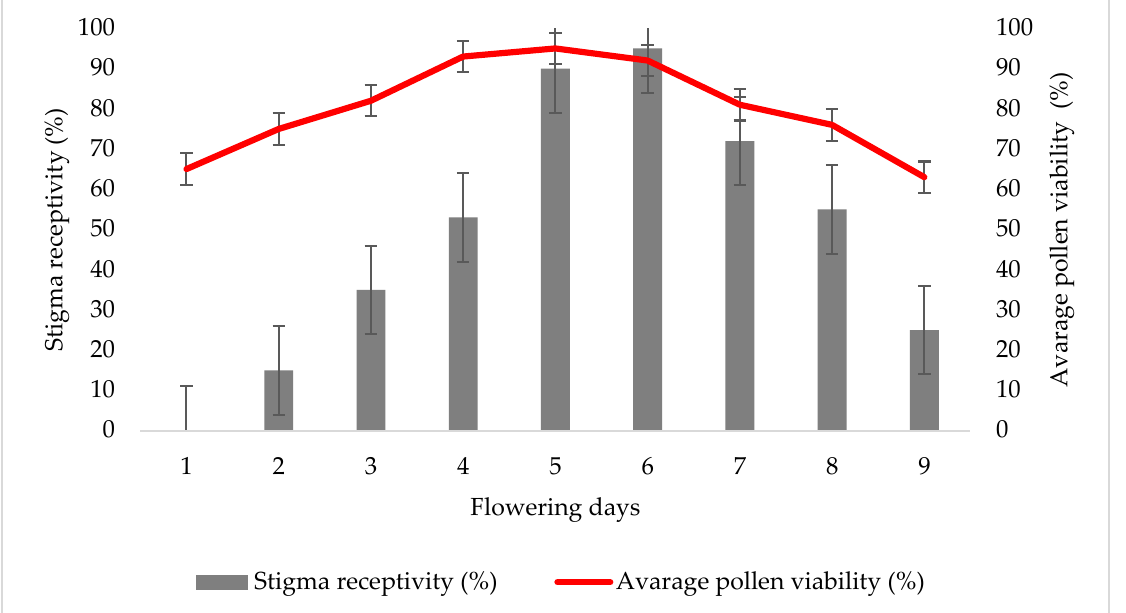
Figure 3. Changes of pollen viability and stigma receptivity during anthesis of F. michailovskyi.